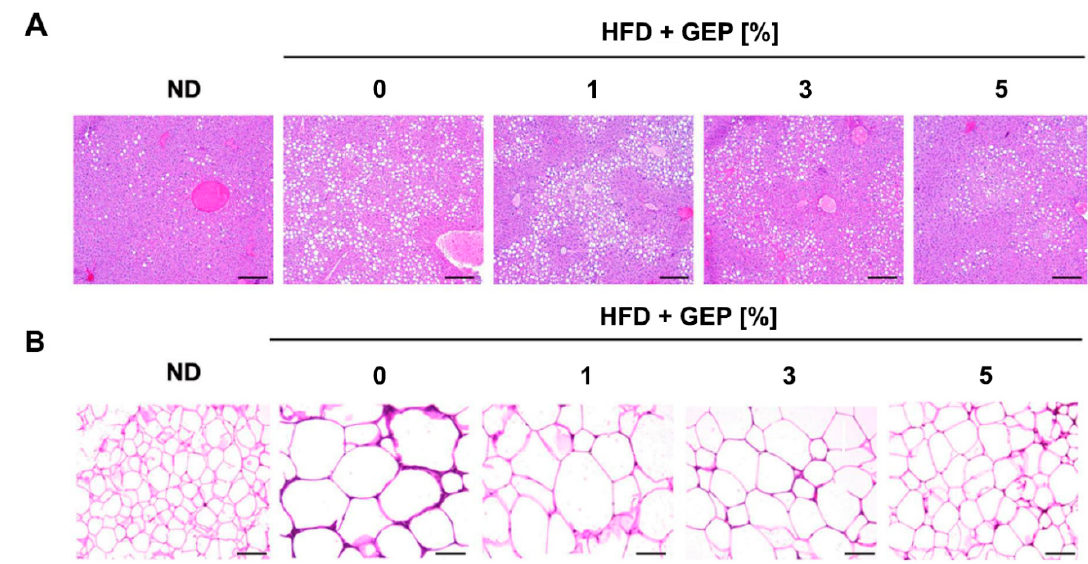
Figure 3. Histological analysis of ( A ) hepatocytes and ( B ) WAT sections using hematoxylin and eosin staining. Fat was lost during processing; white indicates fat. ND: normal chow diet group; HFD: high-fat diet group; HFD + GEP: high-fat diet and Ganoderma lucidum extract powder.